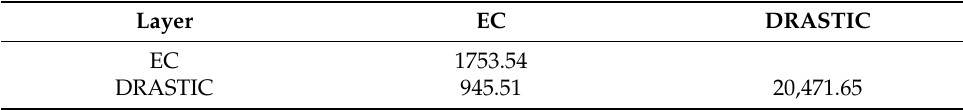
Table 6. Covariance matrix between EC and DRASTIC.